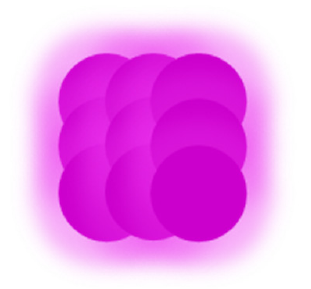
Figure 3. Plasma modification pattern.